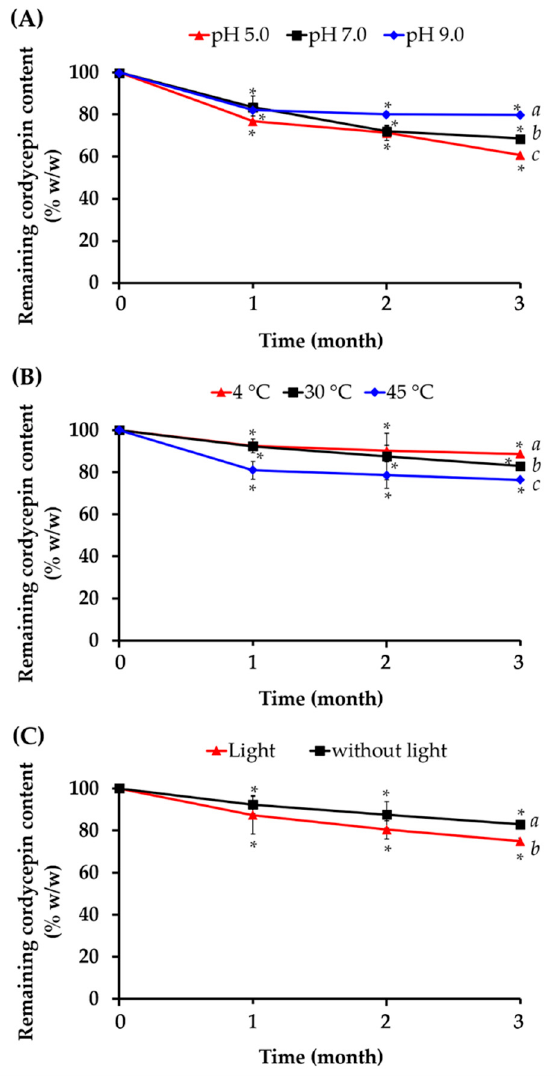
Figure 6. The remaining cordycepin content of C. militaris water extract (CW) stored in various pH conditions ( A ), various temperatures ( B ), and dark/light conditions ( C ). Data are show in mean value ± S.D. ( n = 4). Significant difference of cordycepin content before (day 0) and after 1, 2, and 3 months were analyzed using t-test analysis (* p < 0.05).